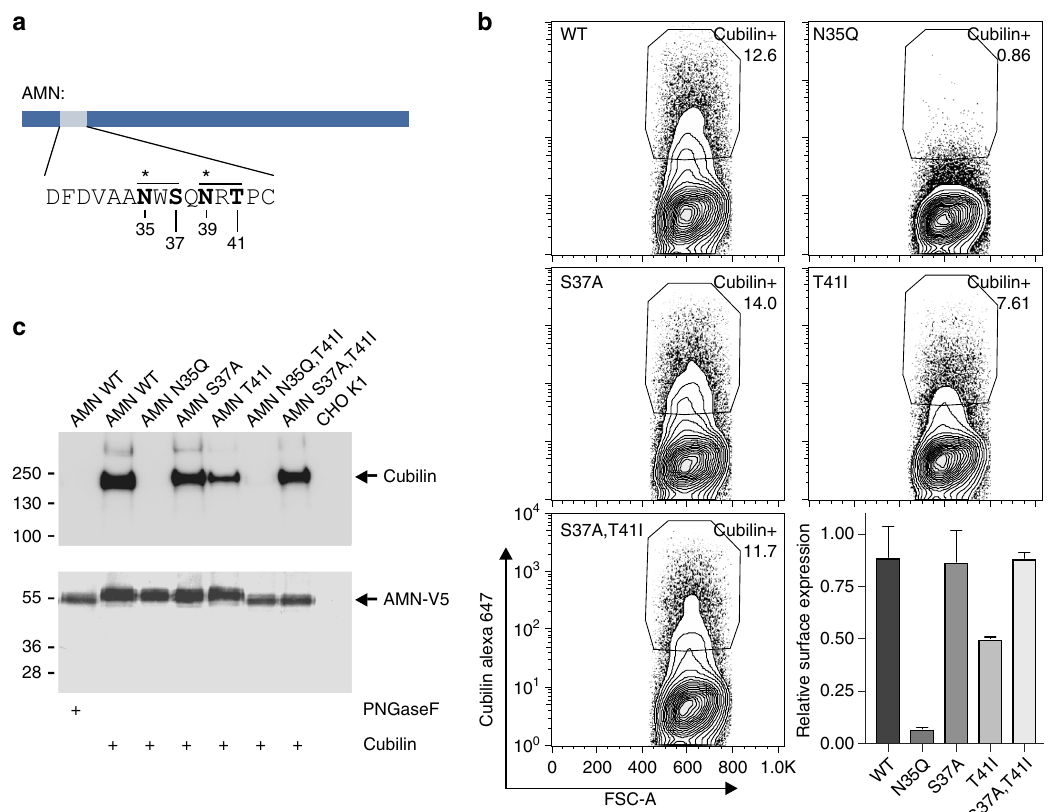
Fig. 5 N-linked glycosylation of AMN. a Consensus sequence motif for potential N-linked glycosylation of AMN. The two consensus sites are marked by lines above the sequence. Potentially glycosylated Asn residues are marked by asterisks. Residues selected for site-directed mutagenesis are marked in bold. b Surface expression of cubilin in transiently transfected CHO K1 cells. Cells were co-transfected with cubilin and AMN wild type or AMN mutants. Live cells were gated in SSC-A and FSC-A and replotted in a contour plot showing Cubilin expression vs. FSC-A. Correct gate for Cubilin expressing cells (Cubilin + ) was set based on non-cubilin expressing control cells (mock transfected). Full gating strategy is shown in Supplementary Figure 3A. Relative surface expression of cubilin is shown in the bottom right corner. As cubilin and AMN expression was established by transient transfection only 10 – 20% of analysed cells co-expressed both proteins (Supplementary Figure 3B). The relative surface expression of cubilin was therefore calculated as % of cubilin + cells (surface expression)/% cubilin + , AMN + cells (total cell stain), experiment was performed in triplicates and error bars represent standard error of mean. c Immunoprecipitation of cubilin with wild type or mutant forms of AMN-V5. The top blot was visualized using rabbit polyclonal anti-rat cubilin antibody followed by Horse-radish peroxidase conjugated goat polyclonal anti-rabbit IgG. The bottom blot was visualized using mouse monoclonal anti-V5 alkaline phosphatase (AP) conjugated antibody. Uncropped blots are shown in Supplementary Figure